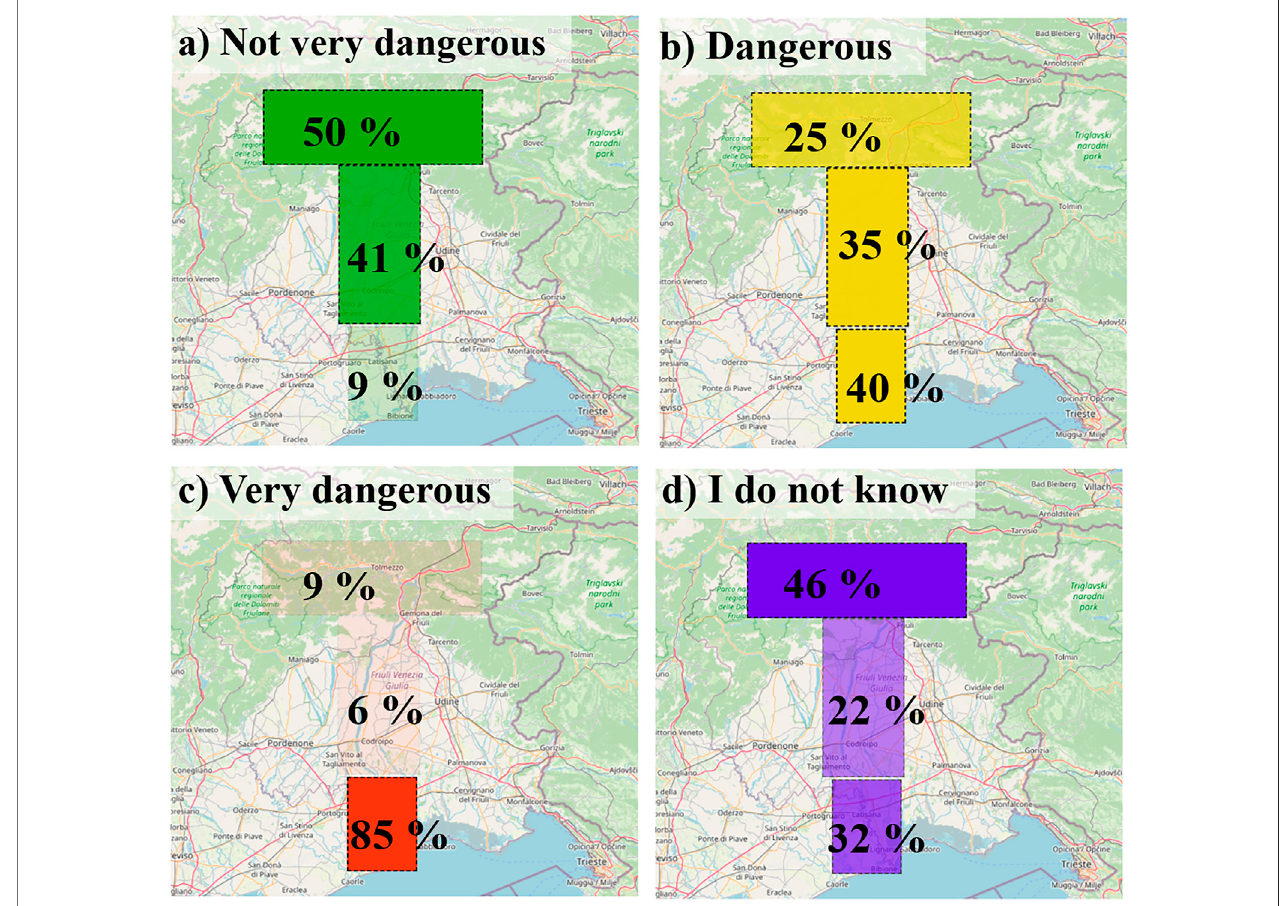
FIGURE 1 | Map of perceived risk responses (Q2). For each area, the percentage of answers assigning the area to the speci fi c level of risk is shown.